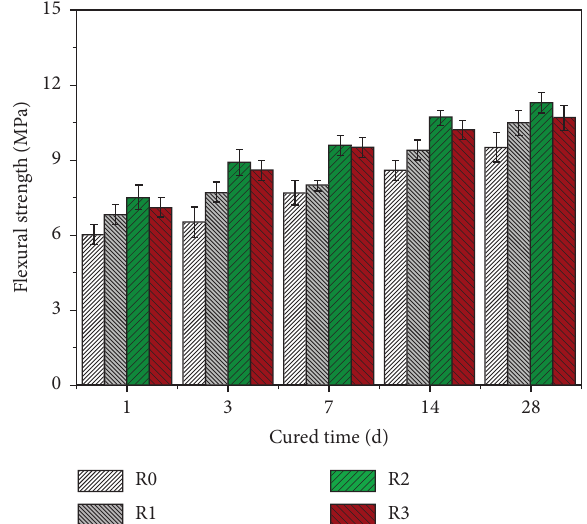
Figure 4: Flexural strength of resin modified cement